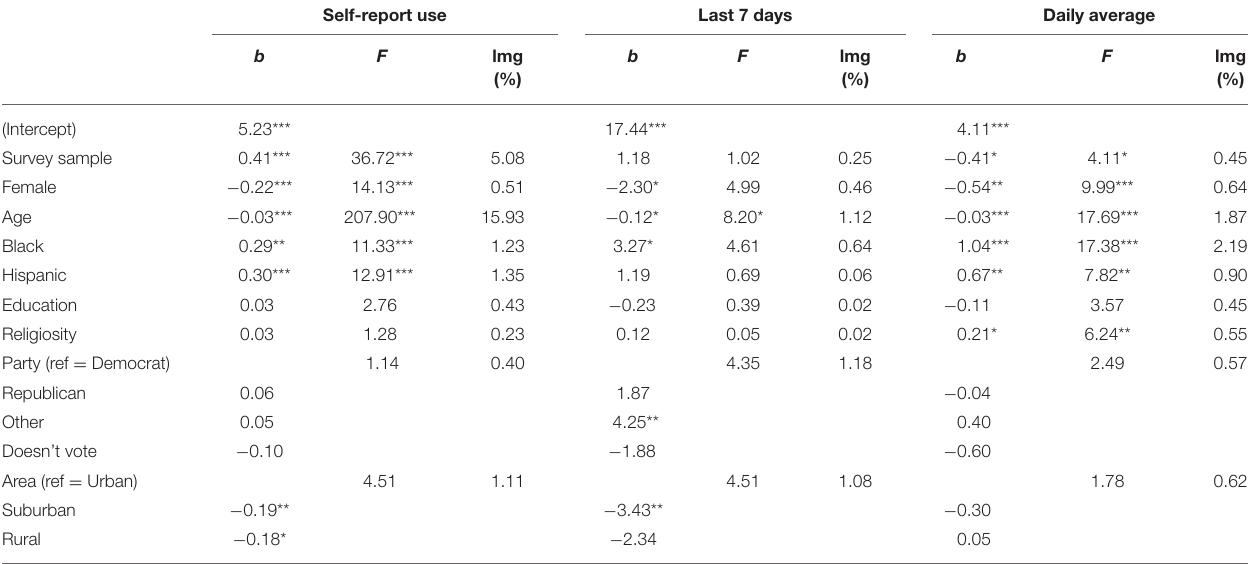
TABLE 1 | Predicting YouTube Use with Survey 1 and 2 participants combined.